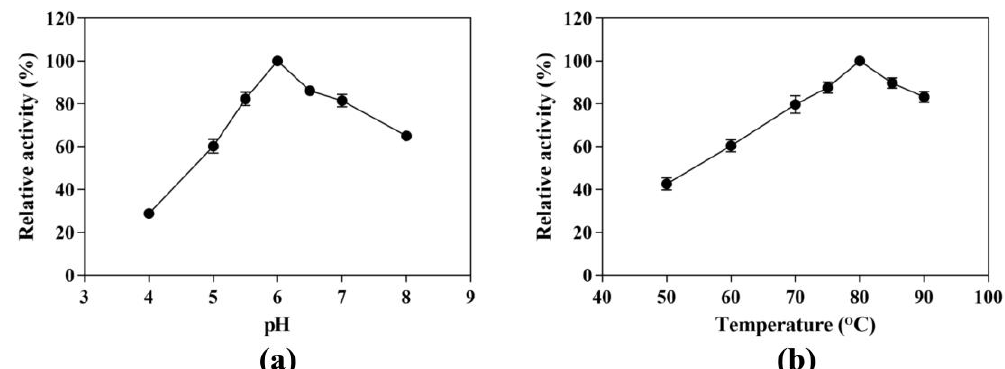
Figure 2. Effects of pH and temperature on the CK-producing activity. ( a ) Effect of pH on the CK-producing activity. The reactions were performed at 80 °C in acetate buffer (50 mM) containing 10 mg/mL SS-bgly and 5 mg/mL ginsenoside substrate for 4 h by varying the pH from 4.0 to 8.0. ( b ) Effect of temperature on the CK-producing activity. The reactions were performed in acetate buffer (50 mM and pH 6.0) containing 10 mg/mL SS-bgly and 5 mg/mL ginsenoside substrate for 4 h by varying the temperature from 50 to 90 °C. Experiments were performed in triplicate. The data represent the means of replicates and the error bars represent standard deviations.